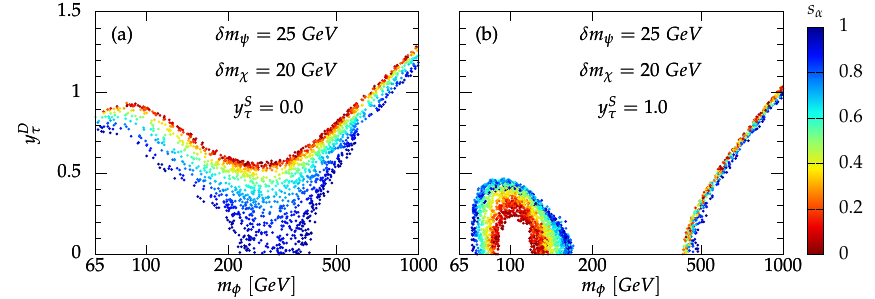
Figure 3 . y D vs m φ correlation for relic density allowed points. In figure 3(a), φψ + coannihilation τ survives for zero mixing and φχ + coannihilation dominates for non-zero values of s α . In figure 3(b), due to large y S , pair annihilation contribution becomes prominent for the large m φ τ